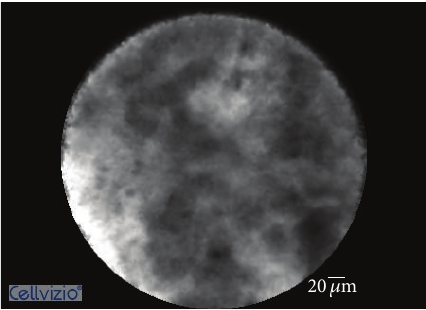
Figure 4: Probe-based confocal laser endomicroscopy imaging showing thickened reticular